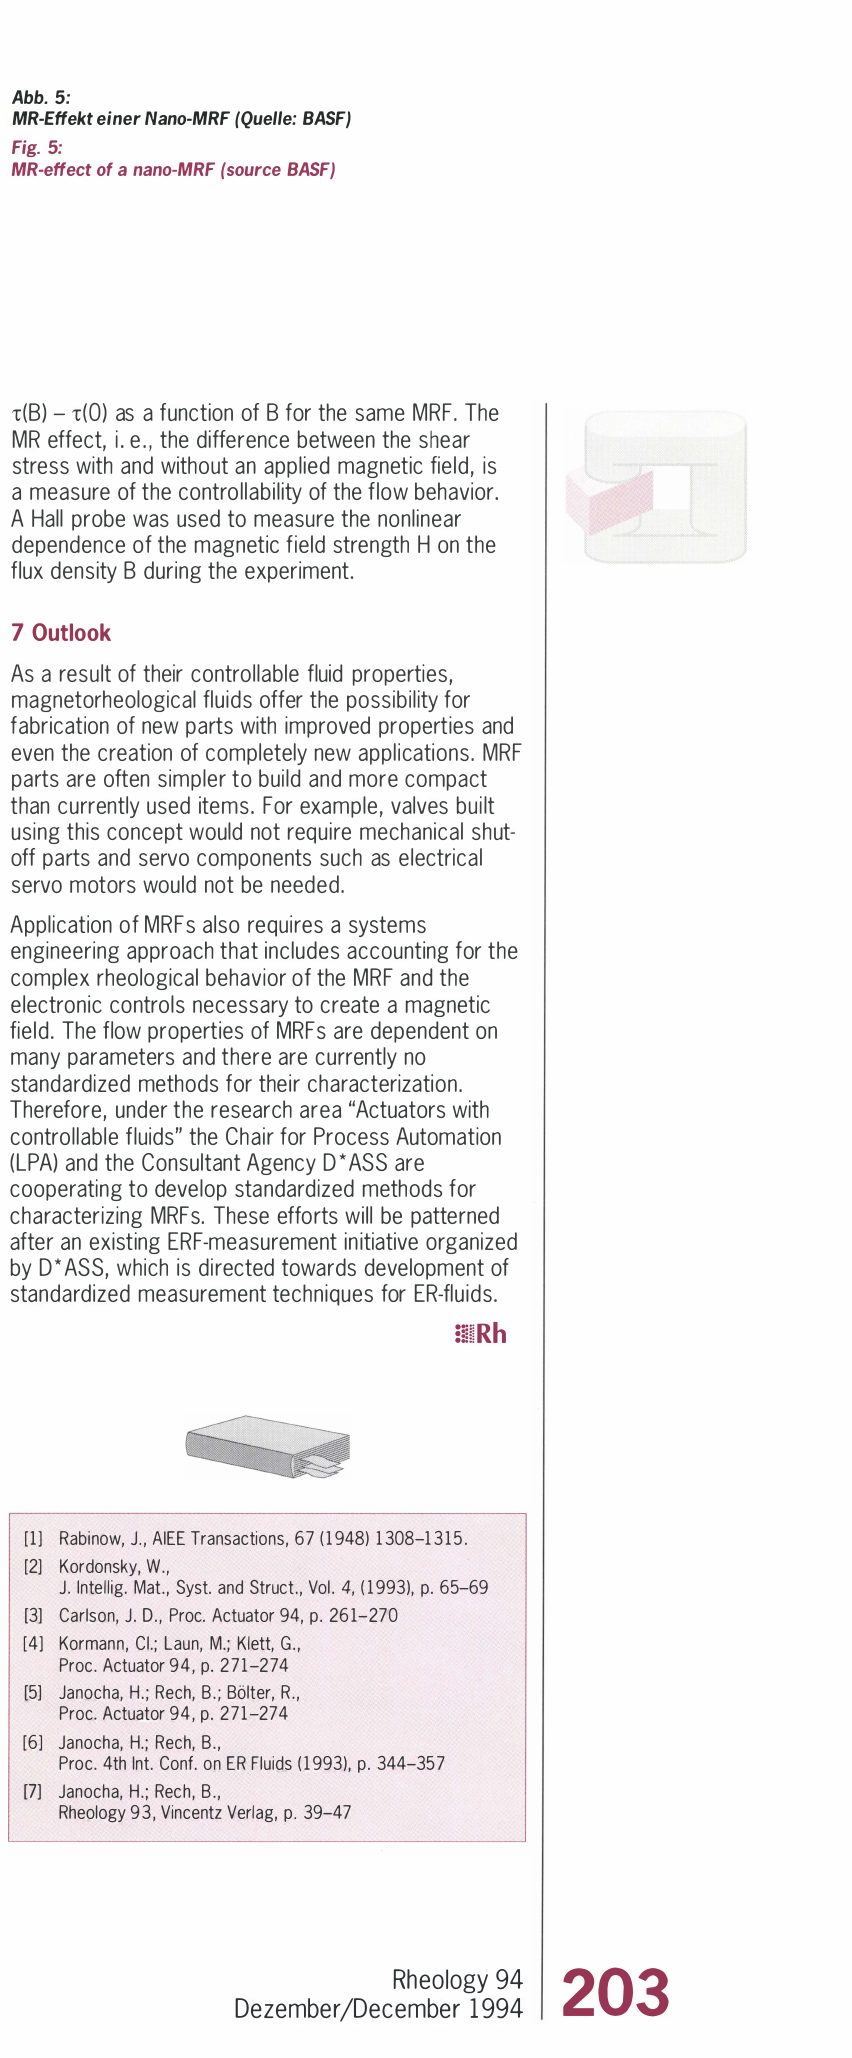
Fig. 5: MR-effect of a nano-MRF (source BASF)